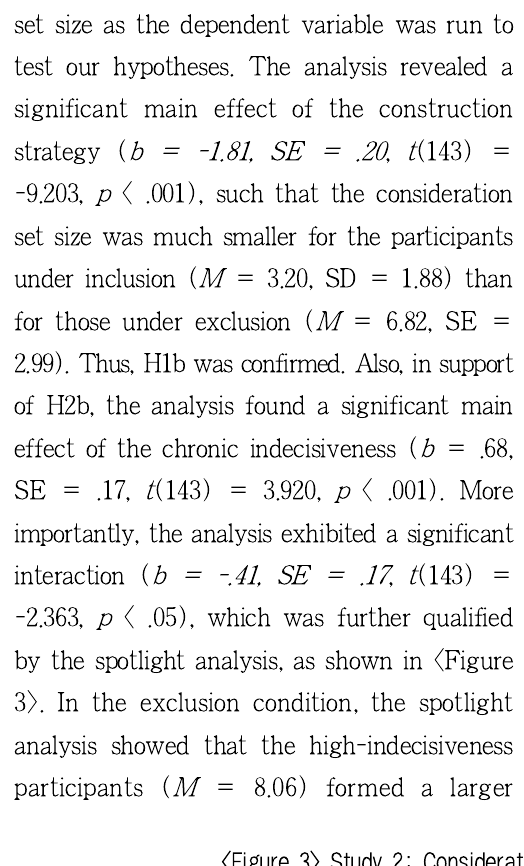
<Figure 3> Study 2: Consideration Set Size (Spotlight